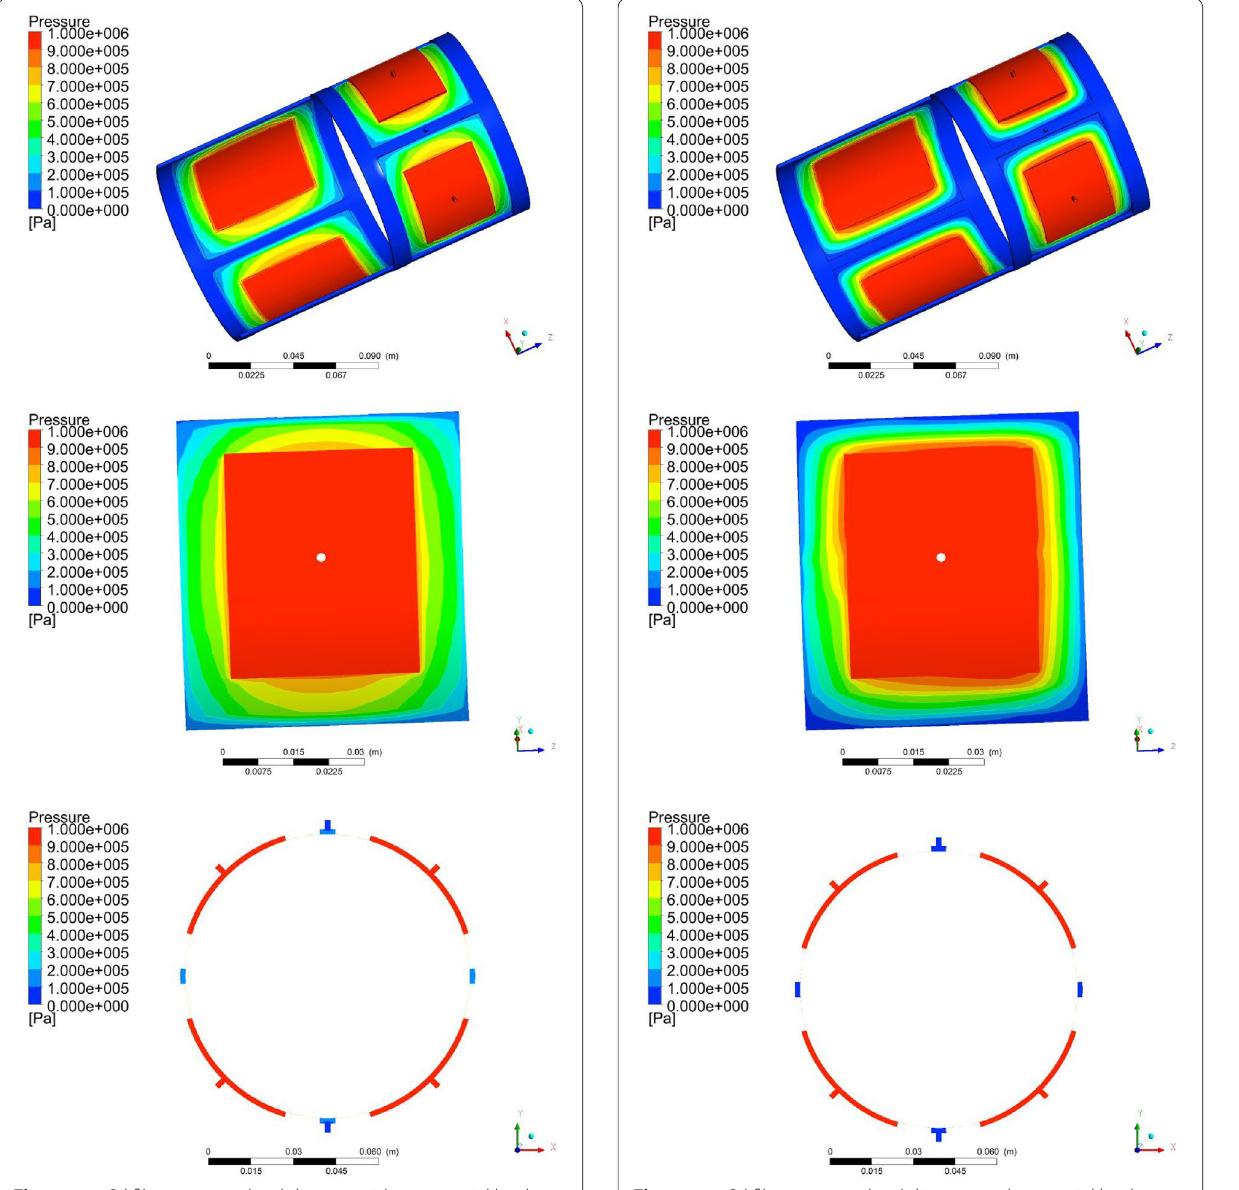
partial load with a value of approximately 998371 Pa. In Figure 17, the black and red dots indicate the pressure at the central sections of the lower oil pads and the upper oil pads, respectively, when the piston rod is subjected to a partial load. The blue and pink dots represent the pressure at the central sections of the lower oil pads and upper oil pads, respectively, when the piston rod is not subjected to a partial load. It is apparent from this figure that when the piston rod is subjected to a partial load, the pressure in the oil chamber is significantly greater than